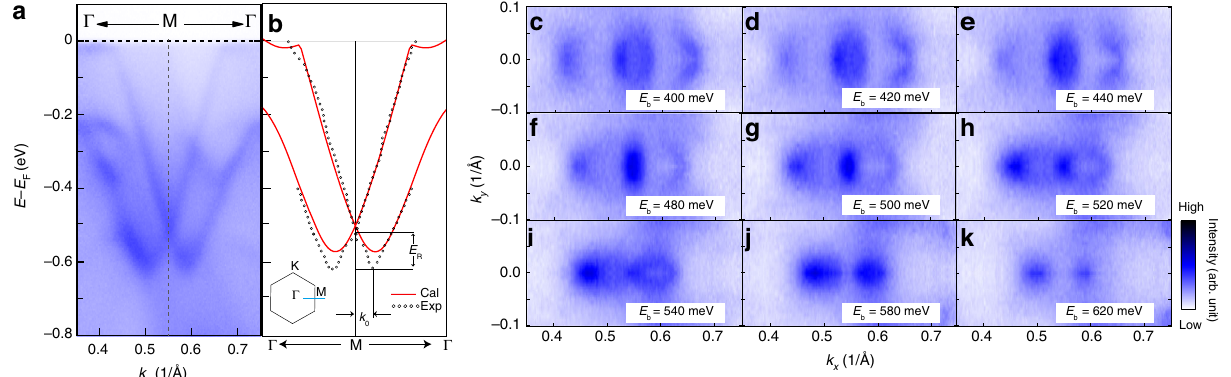
Fig. 2 Rashba-like band splitting around the M point. a Rashba-like band splitting in PtBi 2 at the M point, shown along the Γ – M – Γ direction (indicated by the blue line in the inset of b ) measured by angle-resolved photoemission spectroscopy (ARPES) ( h ν = 9 eV). b Black circles show peak positions of the momentum distribution curves (MDCs) extracted from the ARPES data in a , while red lines represent the corresponding calculated bulk bands. The left inset shows the surface Brillouin zone (BZ) of PtBi 2 . c – k Constant-energy contours obtained by integrating the photoemission spectral weight over a 10 meV energy window at binding energies as